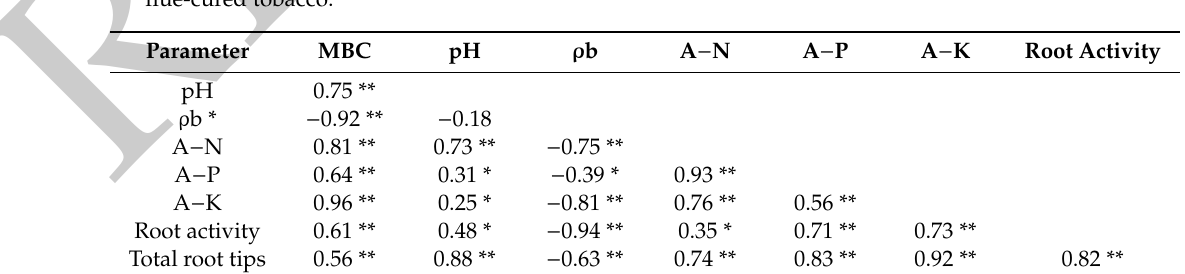
Table 5. Correlation analysis of soil physicochemical indexes and root development of flue-cured flue-cured tobacco.